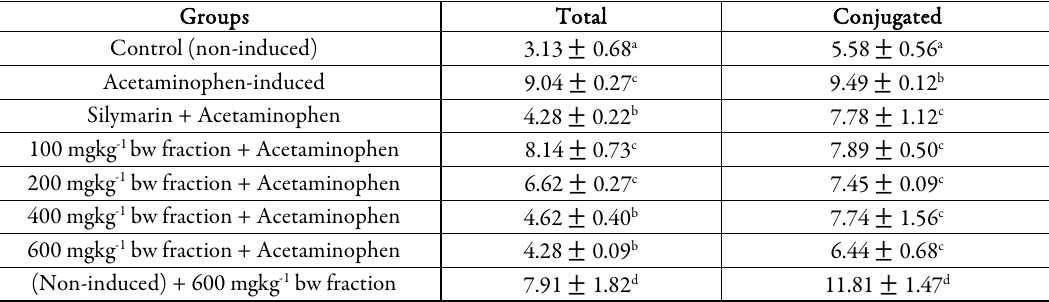
Values are expressed as Mean ± SEM (n = 4). Values along the column with different superscripts are significantly different (P <